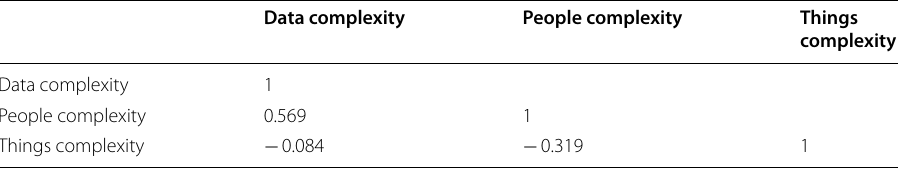
Table 4 Polychoric correlations among the three types of complexity in total sample. Source: PIAAC 2012, DOT index, ISCO-08